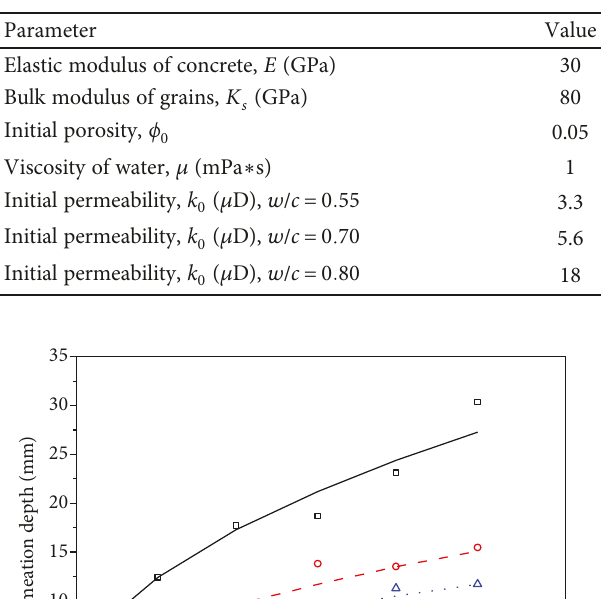
Figure 2: Interaction e ff ect among mechanical deformation, fl uid fl ow, and moving boundary. Table 1: Computational parameters of concrete.